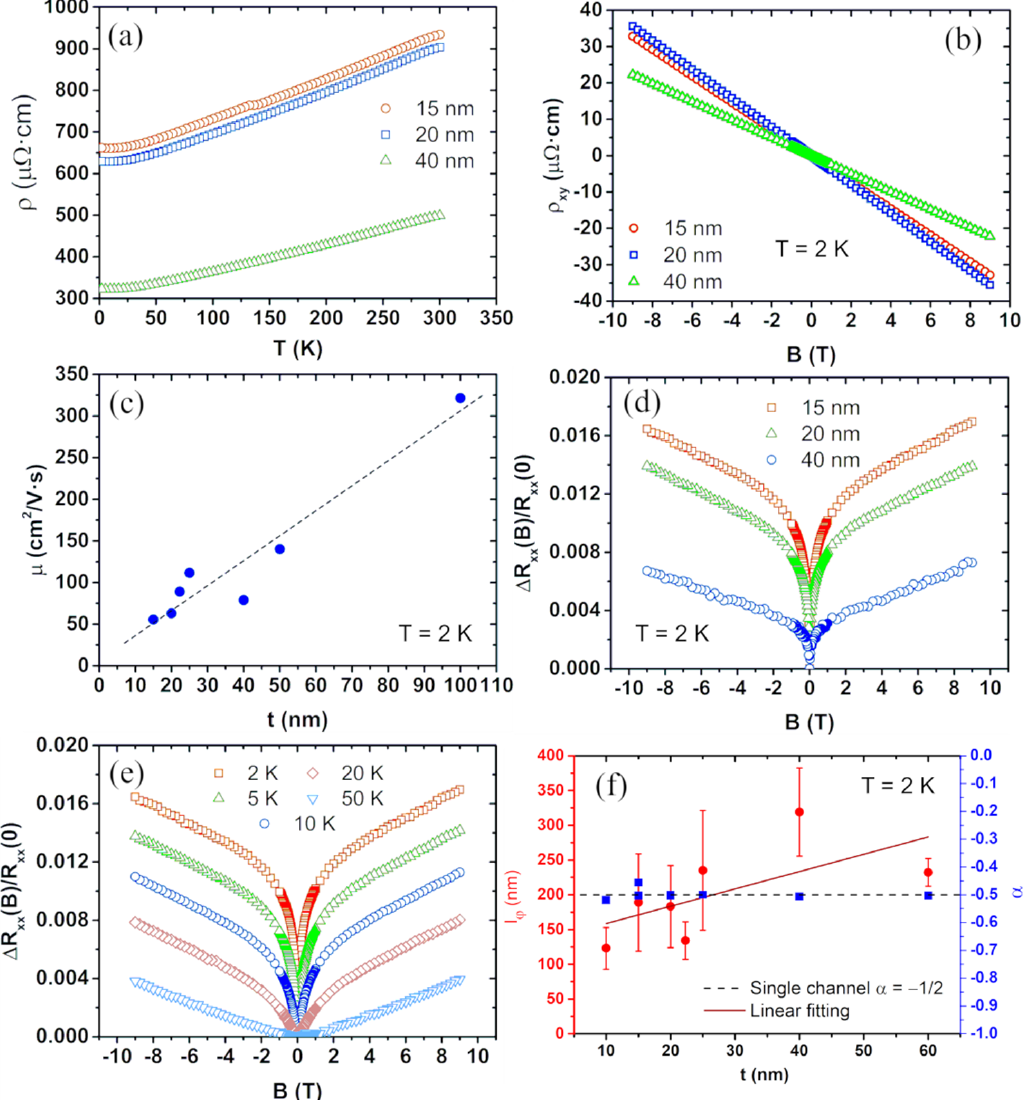
Figure 10. ( a ) Temperature dependence of resistivity for three Bi 2 Se 3 films with different thicknesses showing the metallic behaviour (d ρ /dT > 0 ) . ( b ) Hall resistivity at 2 K against magnetic field for different thicknesses. ( c ) Mobility at 2 K against film thickness. ( d ) Normalized magnetoresistance at 2 K for different thicknesses. ( e ) Normalized magnetoresistance for a 15-nm-thick film at different temperatures. ( f ) Coherent transport parameters l ϕ and α against thickness at 2 K.